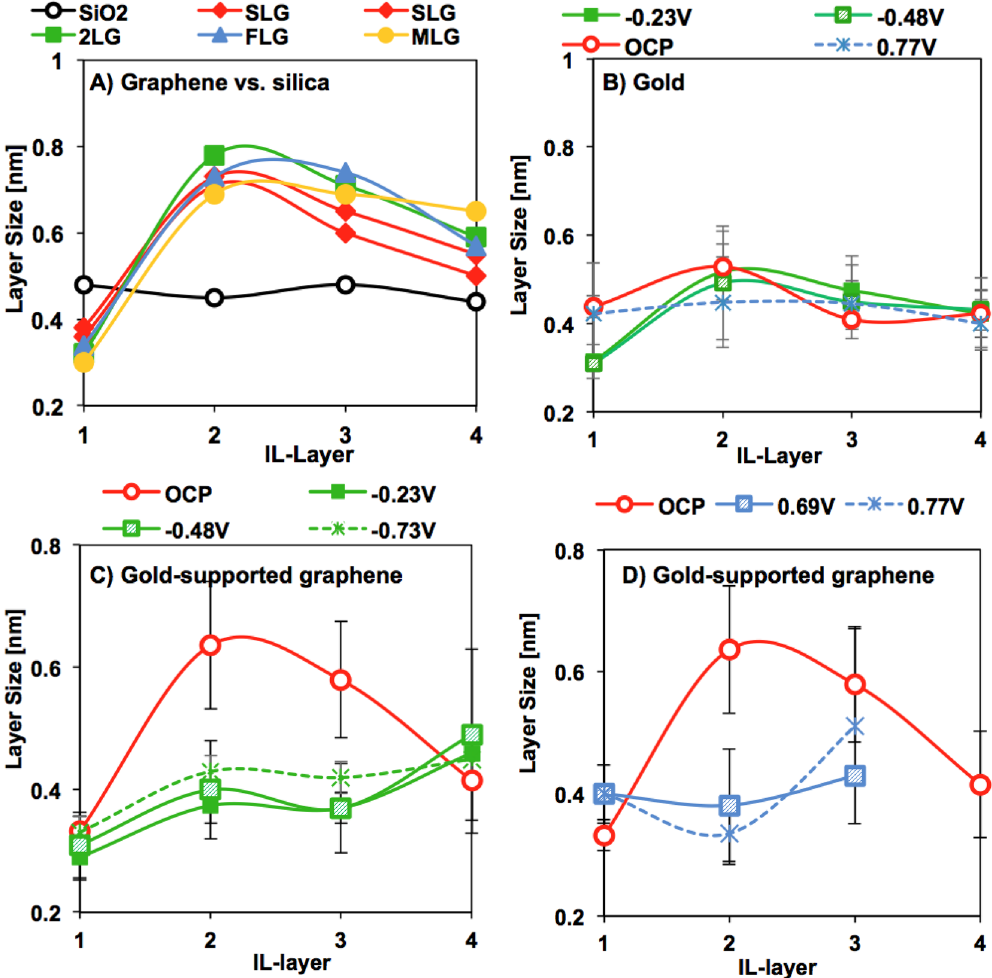
Figure 5. Structure of the extended Stern layer on graphene, and gold and silica supports. The data points give the mean value of the Gaussian distribution fitted to the layer thickness distribution and the variance is shown as an error bar. For ( A ) silica and silica-supported graphene, ( B ) gold, and gold-supported bilayer graphene at ( C ) negative and ( D ) positive